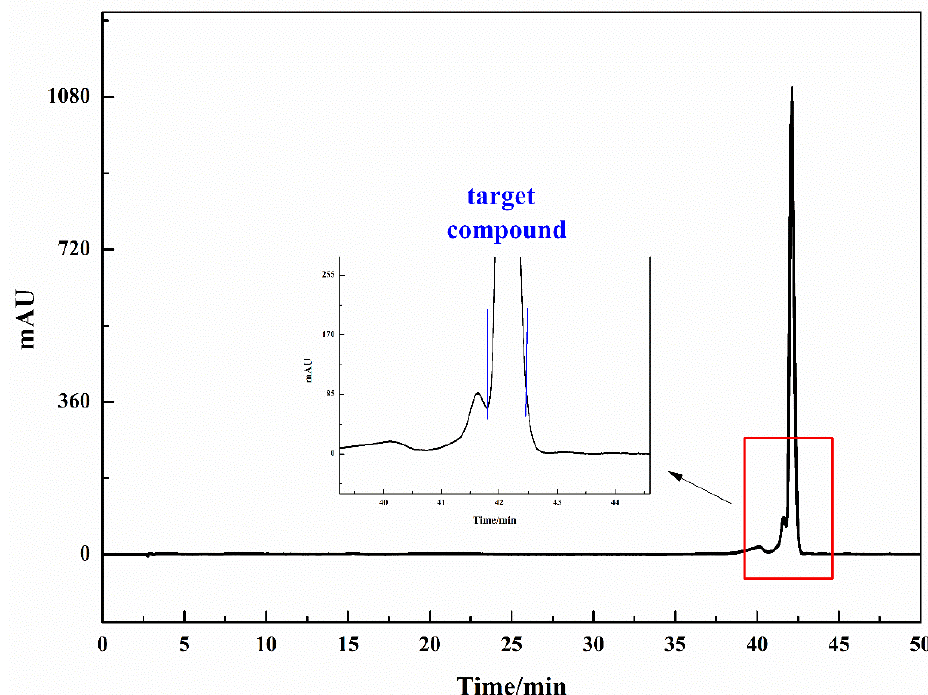
Figure 6. The separation chromatogram of sample Fr-t on the Phecda C18 preparative column. Con- dition: mobile phase A: 0.2% v / v formic acid/water, B: ACN; isocratic elution condition: 0–50 min, 23% B; monitoring wavelength: 254 nm; flow rate: 19.00 mL/min. The target compound was framed by the blue line.